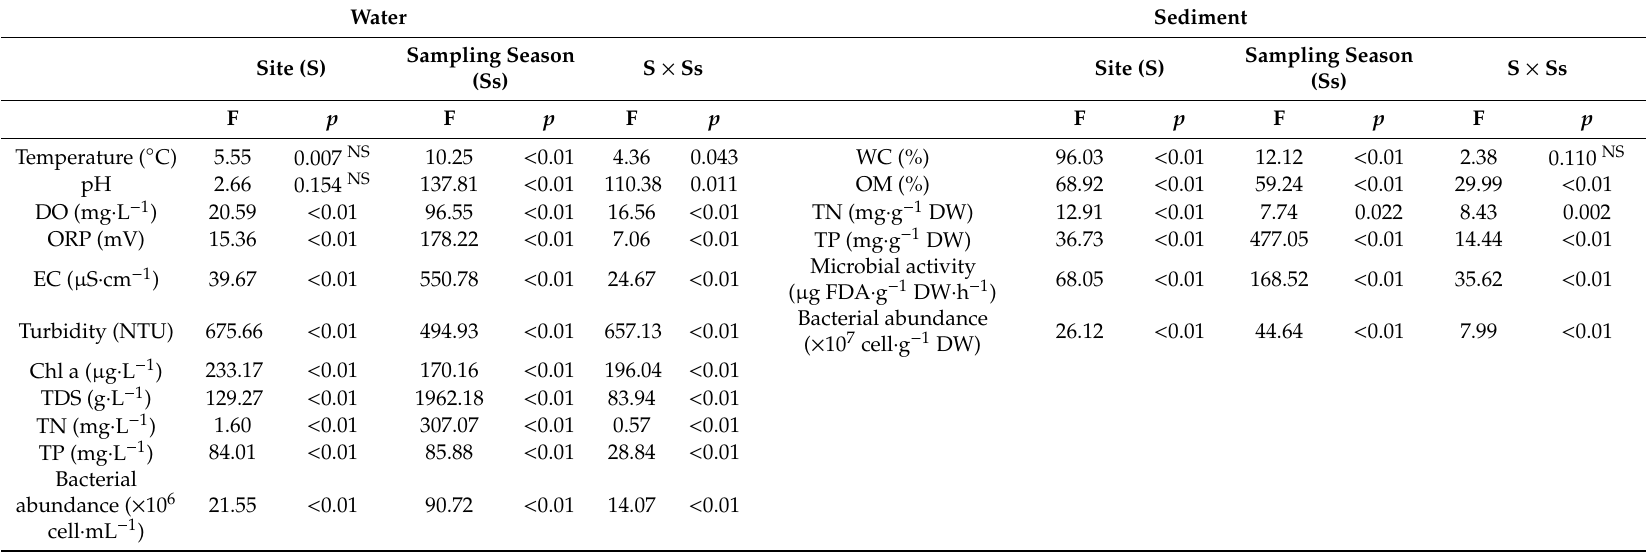
Table 3. E ff ects of site (S1, S2, S3, and S4) and sampling season (dry, normal, and wet) on the physicochemical characteristics of water and sediment by means of repeated measures ANOVA. NS: no significant e ff ect at p =